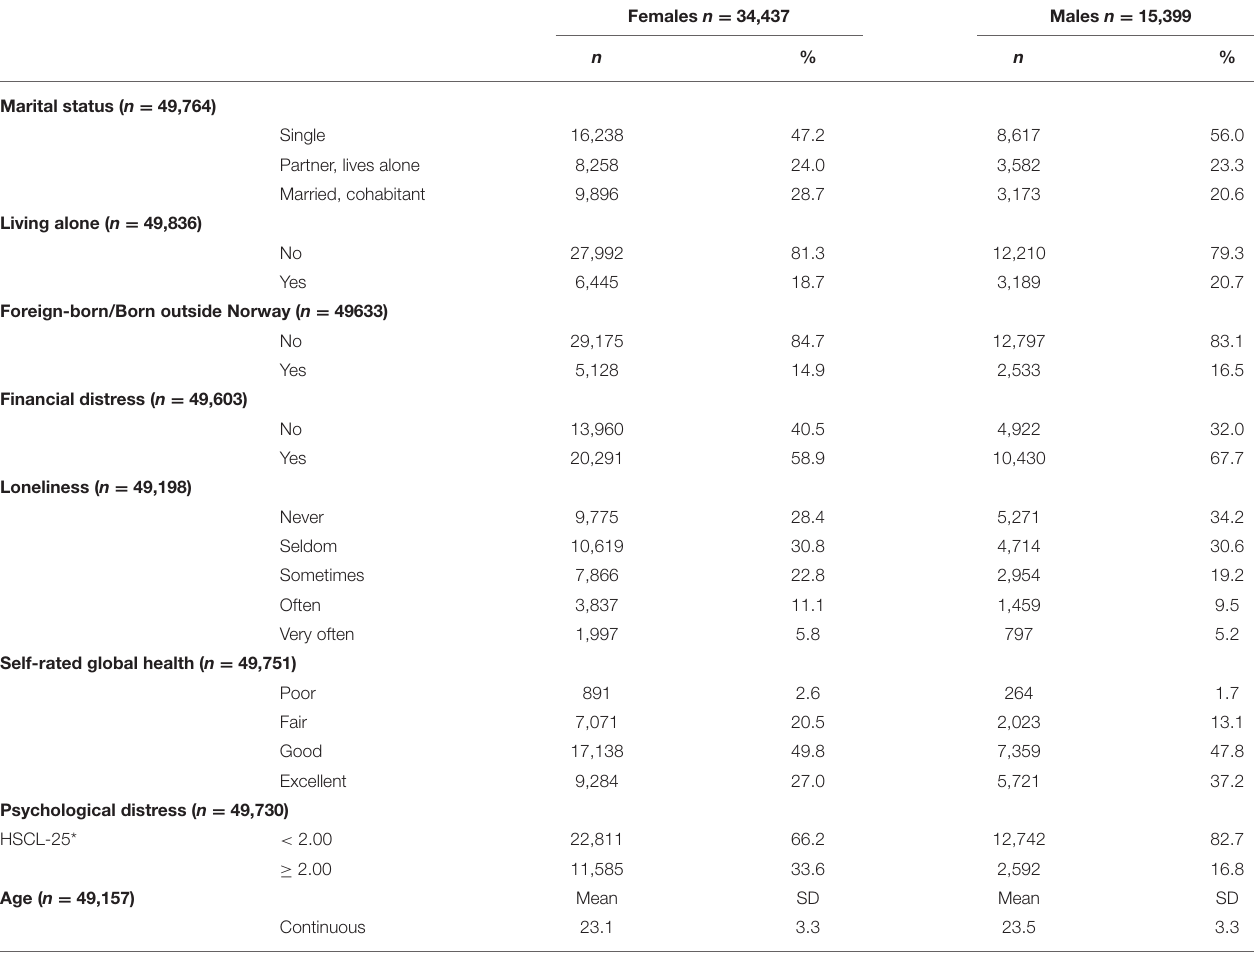
TABLE 1 | Demographic and health characteristics of the student population, gender stratified.